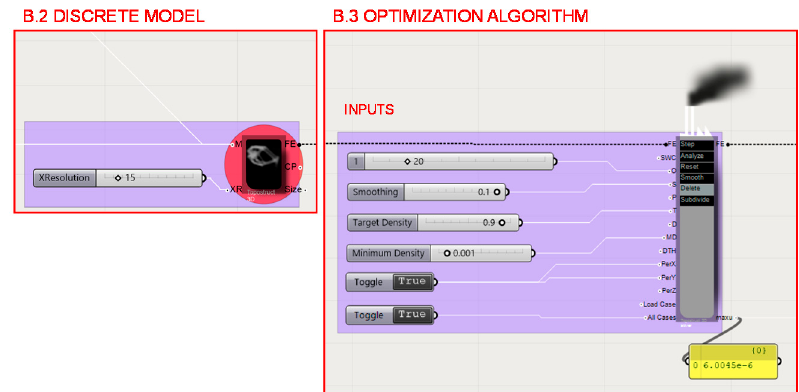
Figure 21. B.2. Programming structure definition of the discrete model for Finite Element Analysis (FEA) developed within the topology optimization algorithm. B.3. Millipede's topology optimization algorithm and the introduced constants as inputs.